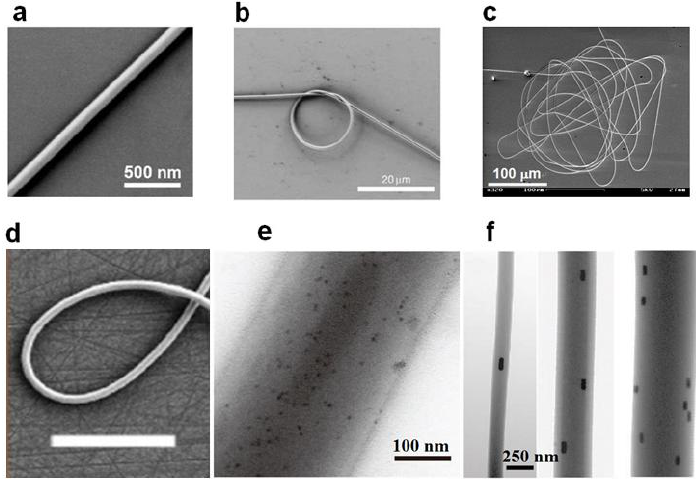
Figure 7. ( a ) SEM image of a 100 nm diameter tellurite glass microfiber [29]; ( b ) SEM image of a 15 mm diameter micro-ring made with a 520 nm diameter silica microfiber [9]; ( c ) A coiled 260 nm diameter silica microfiber with a total length of about 4 mm [9]; ( d ) SEM image of a 350 nm dameter PMMA microfiber. Scale bar: 50 μm; ( e ) A 280 nm diameter polystyrene (PS) microfiber doped with CdSe quantum dots [30]; ( f ) PAM microfiber doped with aligned GNRs